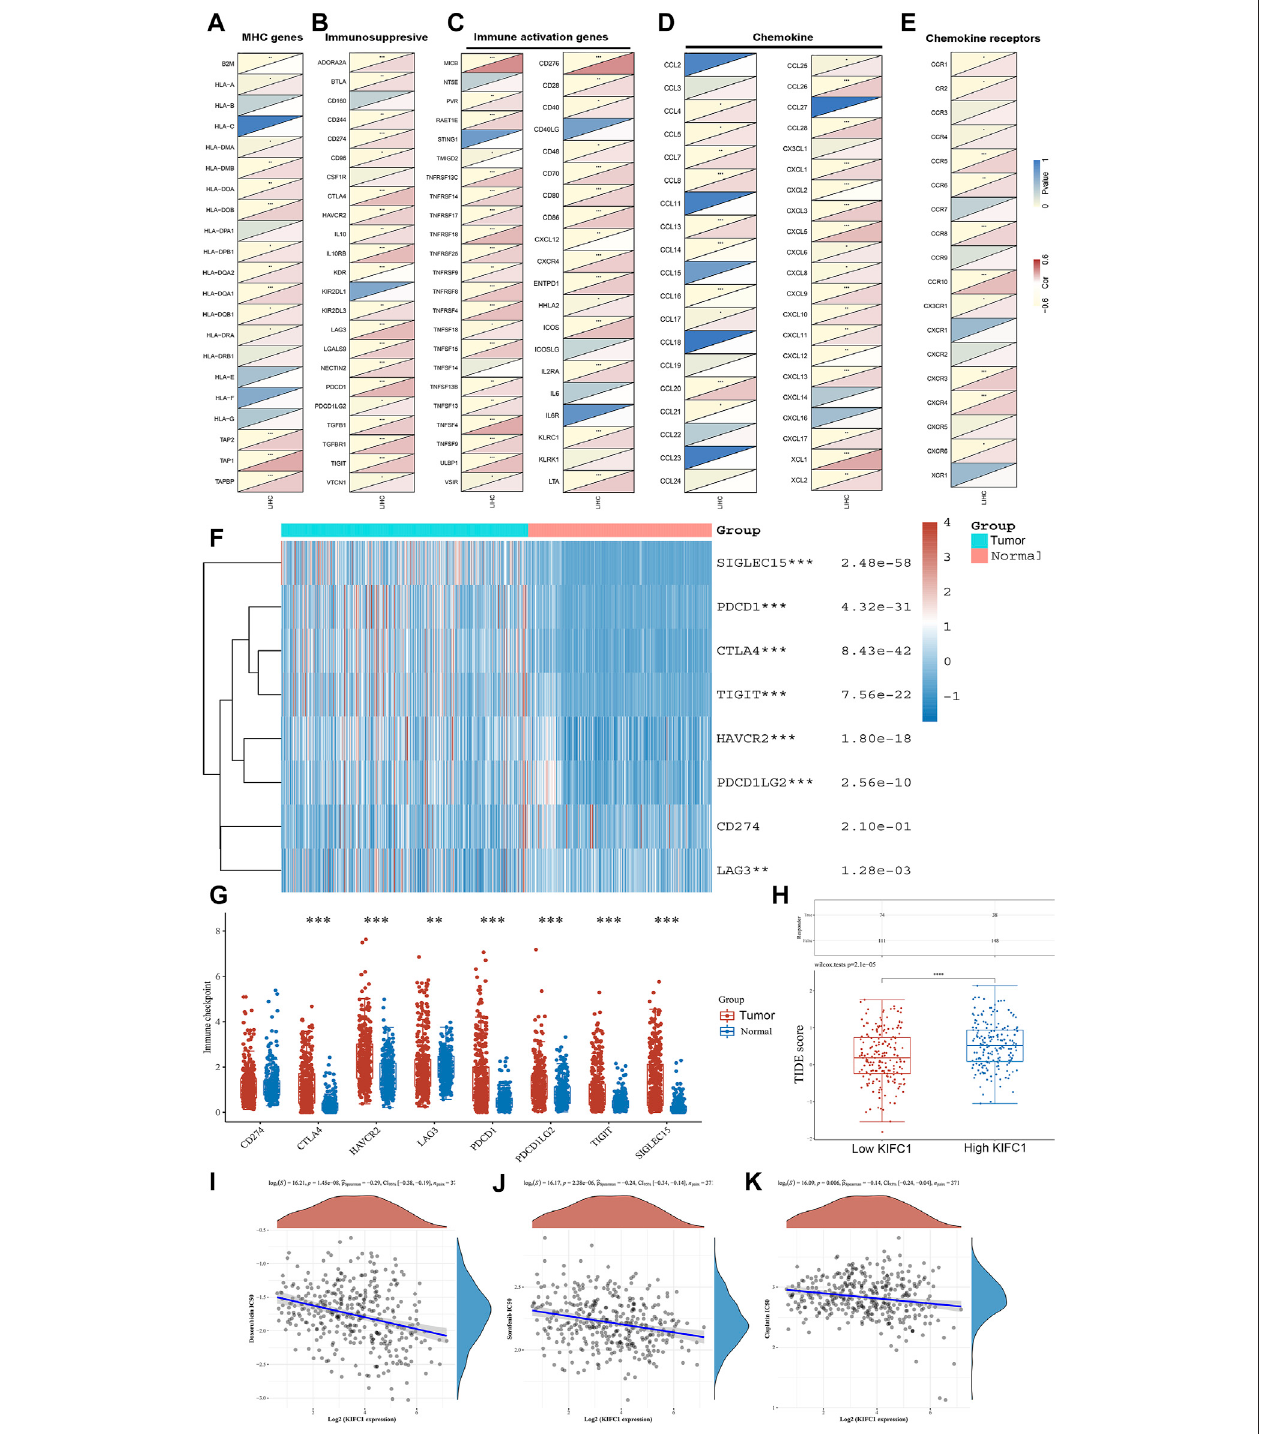
FIGURE 6 | Co-expression of KIFC1 with (A) MHC, (B) immunosuppressive, (C) immune activation, (D) chemokine, and (E) chemokine receptor genes. (F, G) Different expressions of immune checkpoints in LIHC and normal patients. (H) Different responses to ICB therapy in low and high KIFC1 expressions. (I – K) Correlations between KIFC1 and the IC50 of chemotherapy drugs. * p < 0.05, ** p < 0.01, *** p < 0.001.